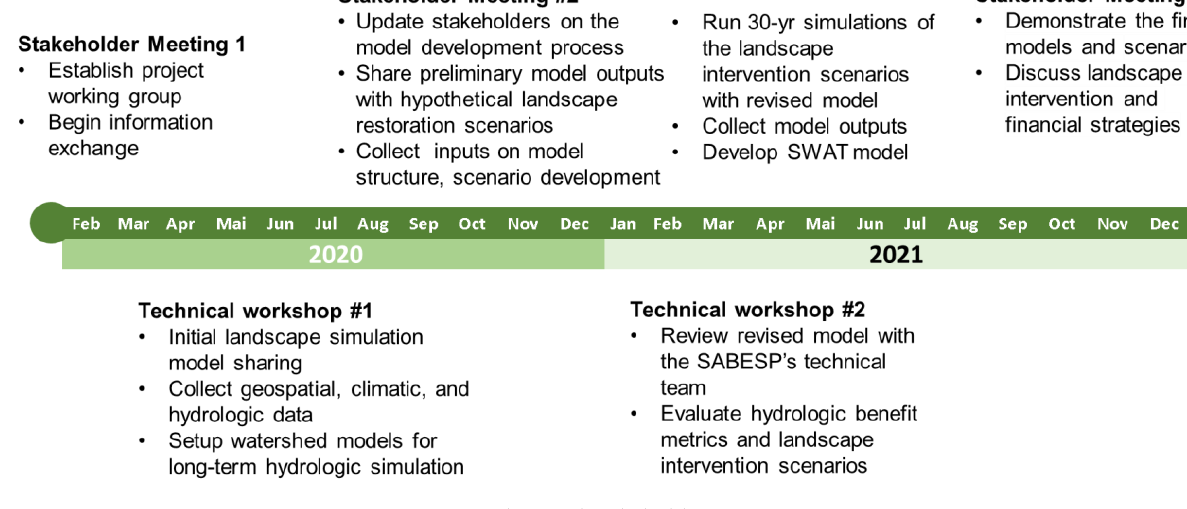
Figure 3. Project timeline and stakeholder engagement process.